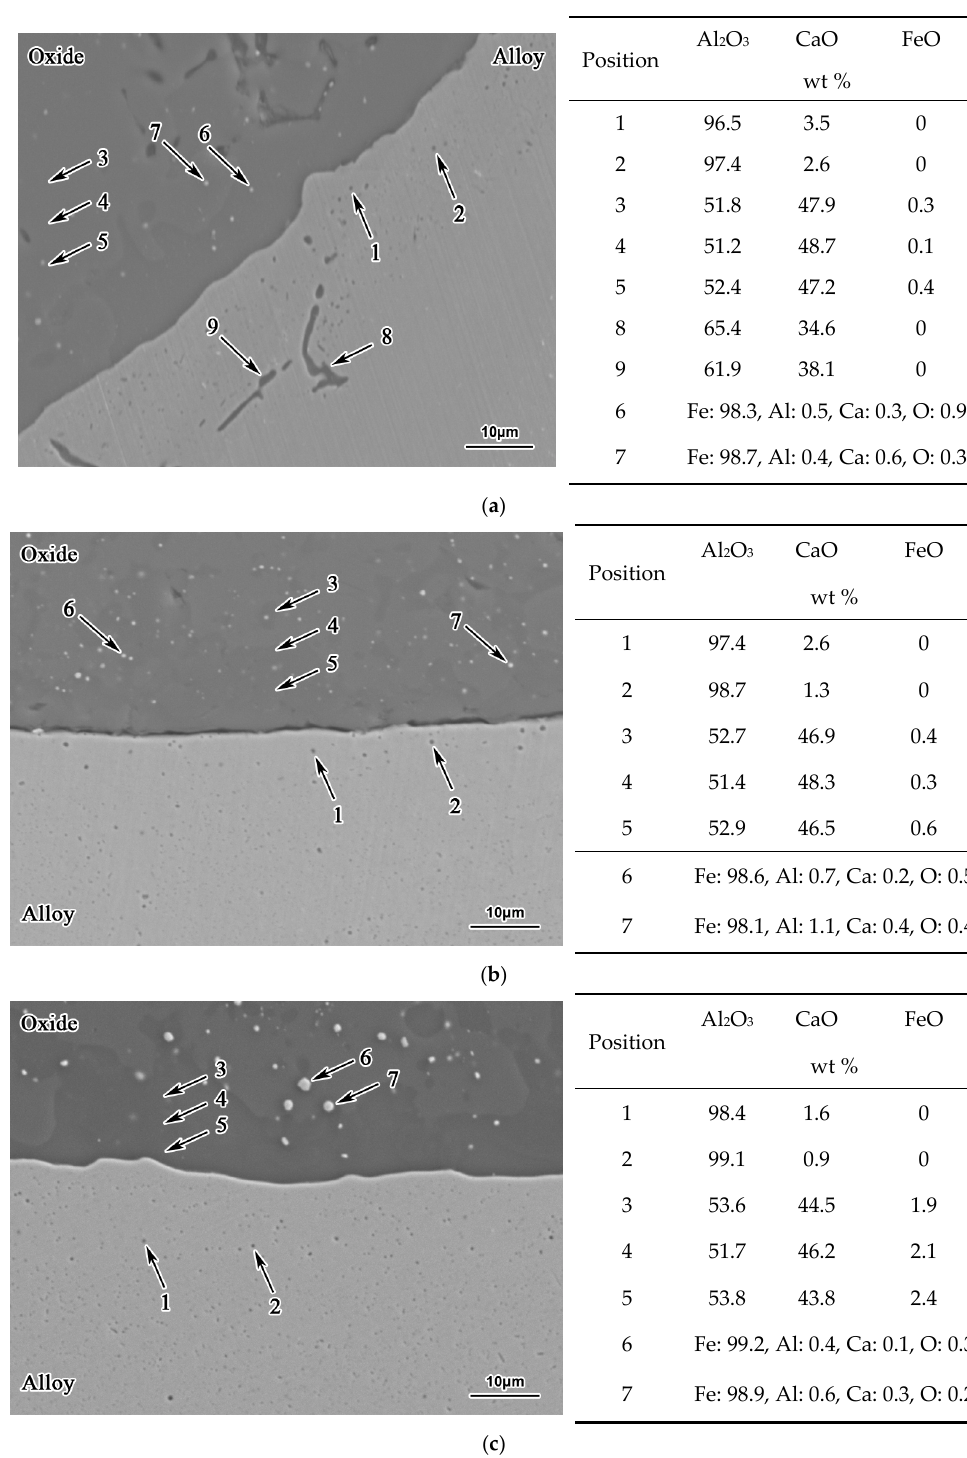
Figure 5. Morphology of interface between the alloy and oxide in the diffusion couple of G0, G1, and G2 after the heat treatment at 1473 K for 10 h: ( a ) G0-10; ( b ) G1-10; ( c ) G2-10.